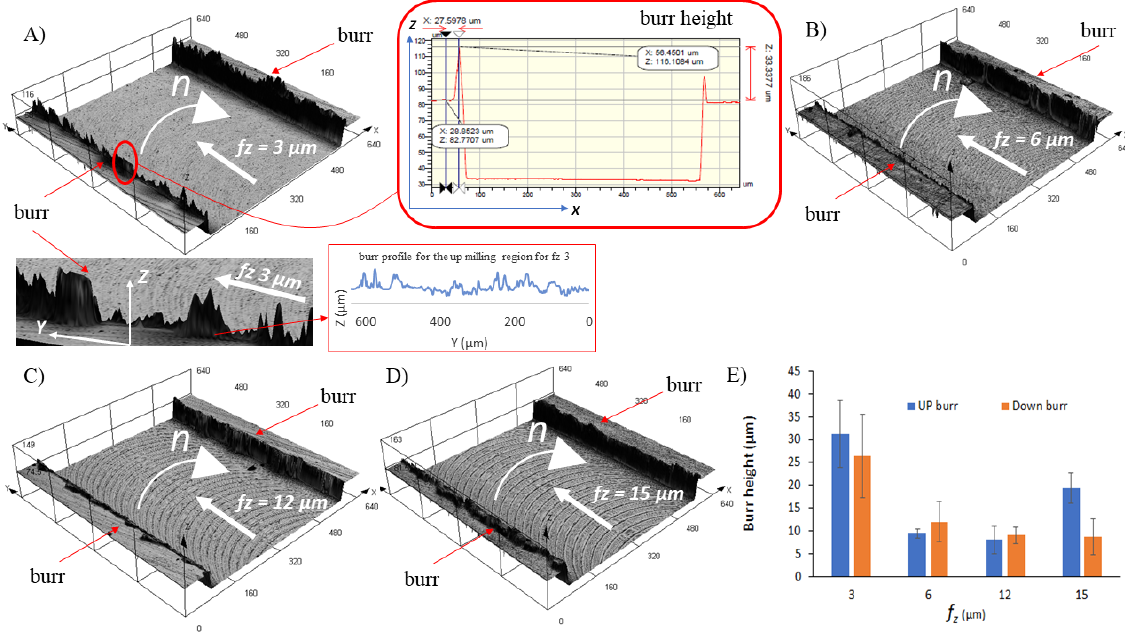
Figure 5: 3D topographies for channels manufactured with different feeds per tooth. A) fz = 3 µm. B) fz = 6 µm. C) fz = 12 µm. D) fz = 15 µm. E) Graph of burr height as a function of feed per tooth.